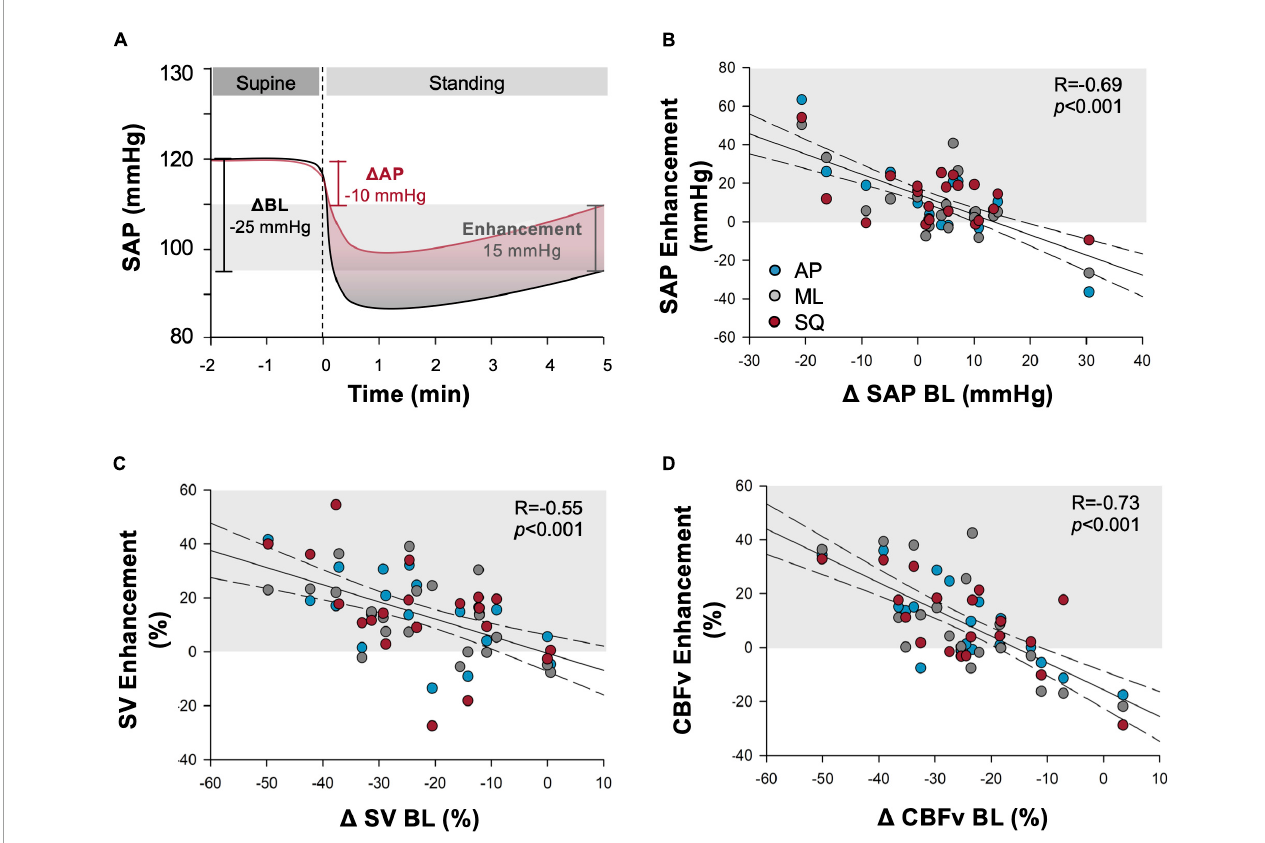
FIGURE5 Cardiovascular enhancements from exaggerated sway. (A) Example depiction of the “enhancement” outcome measure calculation. Change (upright-supine) in cardiovascular measure during exaggerated sway is subtracted from change during baseline (BL) stand. Outcome quantifies the improvement provided by exaggerated sway in comparison to the deficit experienced during quiet standing. Light grey shading shows magnitude of enhancement experienced. Additional panels report correlations between the enhancement produced by exaggerated postural sway and baseline cardiovascular responses shown across outcomes of (B) systolic arterial pressure (SAP), (C) stroke volume (SV), (D) cerebral blood flow (CBFv) during anterior-posterior (blue), mediolateral (grey) and square (red) patterns of exaggerated sway. Baseline cardiovascular responses were calculated as the change from supine values. Regression lines are shown in black solid lines, and 95% confidence intervals shown with dotted lines. Light grey shading indicates responses that showed cardiovascular benefit during exaggerated sway. Participants experiencing larger decrements in cardiovascular (SAP, SV) and cerebrovascular (CBFv) parameters during prolonged quiet standing in the BL sway condition experienced greater benefit from enhanced postural sway.